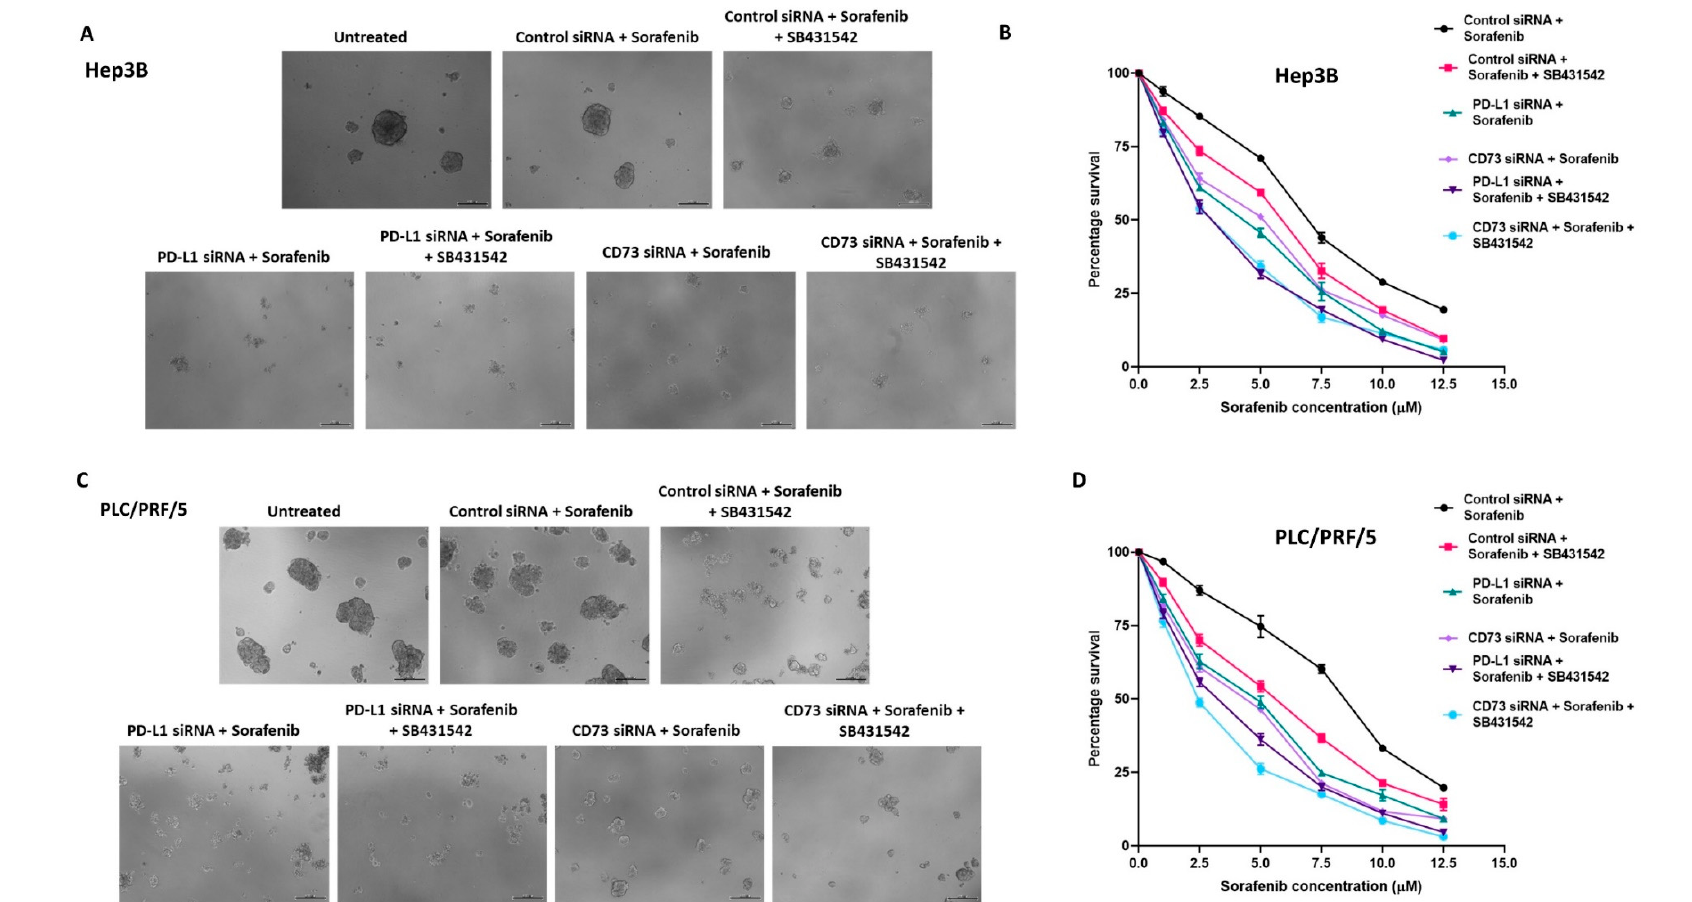
Figure 8. Combined targeting of EMT and immune checkpoint molecules enhanced the cytotoxicity of Sorafenib against human HCC-derived spheres. ( A ) Day 5 images of Hep3B-derived spheres revealed a decreased sphere size as a result of increased cytotoxicity of Sorafenib when combined with SB431542 and PD-L1 or CD73 siRNA compared to Sorafenib alone (scale bar = 200 µm). ( B ) Cell viability assay revealed reduced viability of Hep3B-derived spheres following combination treatment of Sorafenib with SB431542 and PD-L1 siRNA or CD73 siRNA compared to Sorafenib alone. ( C ) Day 5 images of PLC/PRF/5-derived spheres demonstrated increased cytotoxicity of Sorafenib when combined with SB431542 and PD-L1 siRNA or CD73 siRNA compared to Sorafenib alone with decreased sphere size (scale bar = 200 µm). ( D ) Cell viability assay revealed reduced viability of PLC/PRF/5-derived spheres following combination treatment of Sorafenib with SB431542 and PD-L1 siRNA or CD73 siRNA compared to Sorafenib alone.